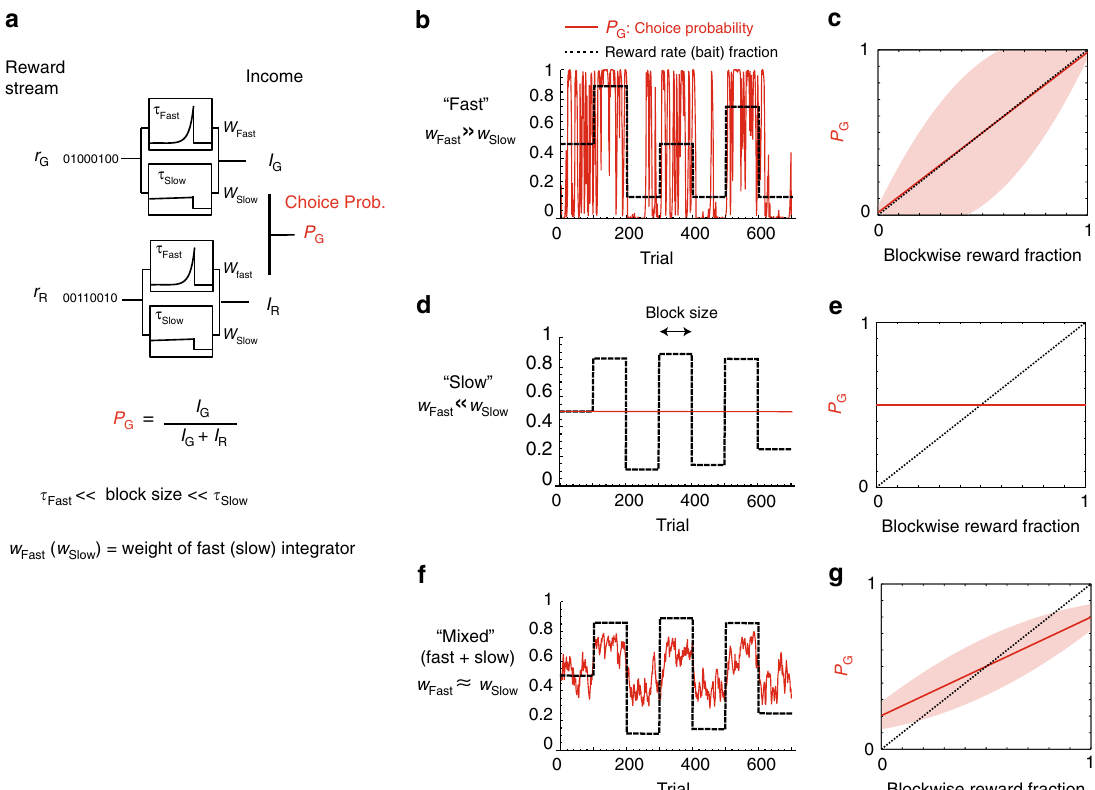
Fig. 2 Model analysis: how slow reward integration leads to undermatching. a Scheme of a model. The model integrates reward history over two timescales ( τ Fast , τ Slow ) to estimate the expected income for each choice (red or green). These incomes are then combined to generate stochastic decisions, where P G ( P R = 1 − P G ) is the probability of choosing the green (red) target. While previous models 18,25 focused on the integration timescales that are shorter than the block size, here we assume that the long timescale τ Slow is much longer than the block size, while the short timescale τ Fast is still shorter than the block size. The model integrates the incomes estimated over the two timescales with adjustable relative weights: w Fast for the relative weight of the